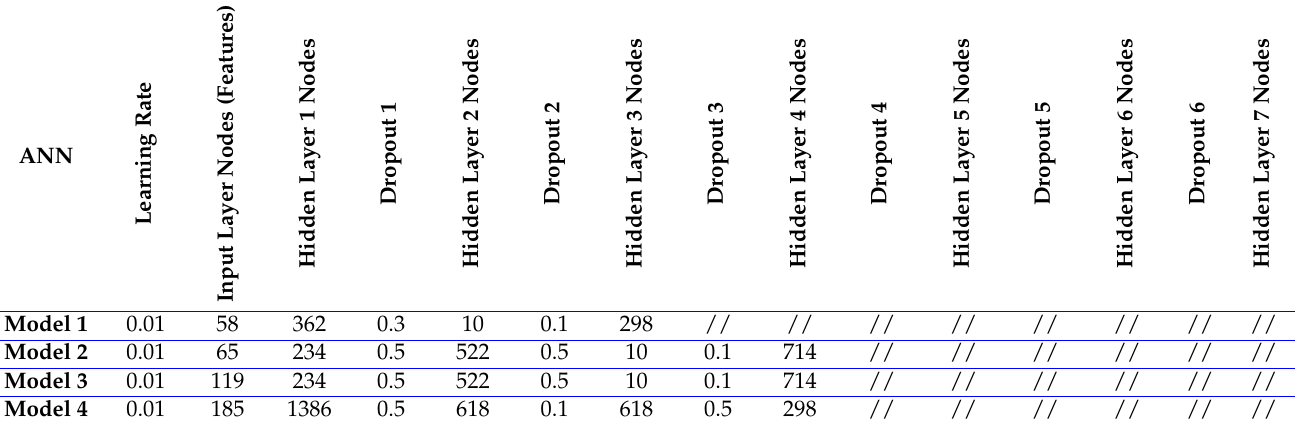
Table A4. Optimal hyperparameters for the ANN models (s-serie laser